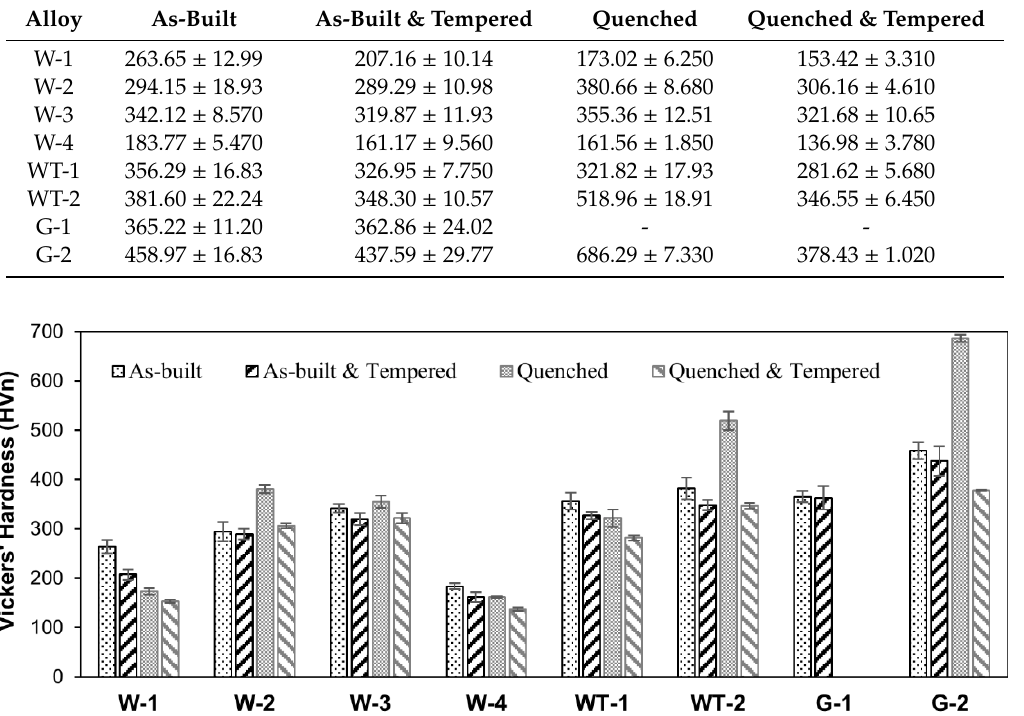
Figure 10. Evolution of microstructure in G-1 and G-2 steels with increasing tempering temperature. Tempering at: ( a ) 200 °C, ( b ) 400 °C, ( c ) 600 °C for G-1 steel; tempering at: ( d ) 200 °C, ( e ) 400 °C, ( f ) 600 °C for G-2 steel (yellow arrows in FE-SEM indicate examples of the dispersed carbides revealed as tiny white dots). Table 5. Vickers’ microhardness of the investigated steels.